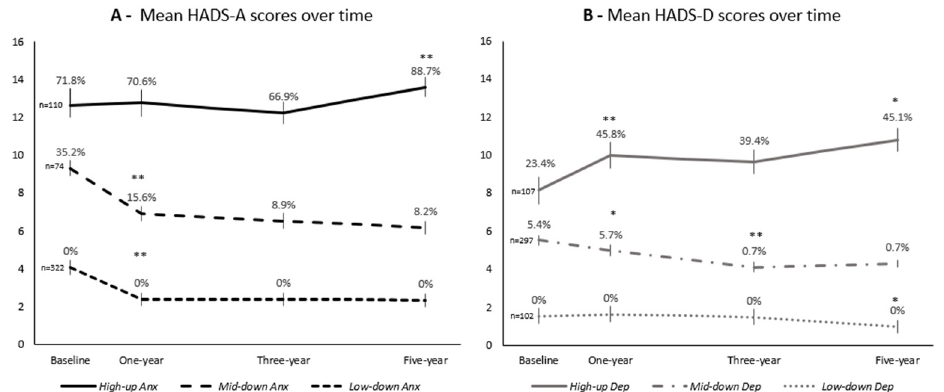
Figure 1. Variation in anxiety ( A ) and depression ( B ) symptoms over the five-year follow-up since breast cancer diagnosis, according to anxiety and depression symptoms trajectories-based groups ( High-up Anx , Mid-down Anx , and Low-down Anx , and High-up Dep , Mid-down Dep , and Low-down Dep , respectively). Graphics obtained using Microsoft Excel software. HADS-A—anxiety subscale of the Hospital Anxiety and Depression Scale; HADS-D—depression subscale of the Hospital Anxiety and Depression Scale. Vertical lines represent the 95% confidence interval of mean values. Percentages refer to women with clinically significant symptoms of anxiety ( A ; HADS-A ≥ 11) or depression ( B ; HADS-D ≥ 11). * p < 0.05 for comparison of scores between precedent and present evaluation. ** p < 0.001 for comparison of scores between precedent and present evaluation.